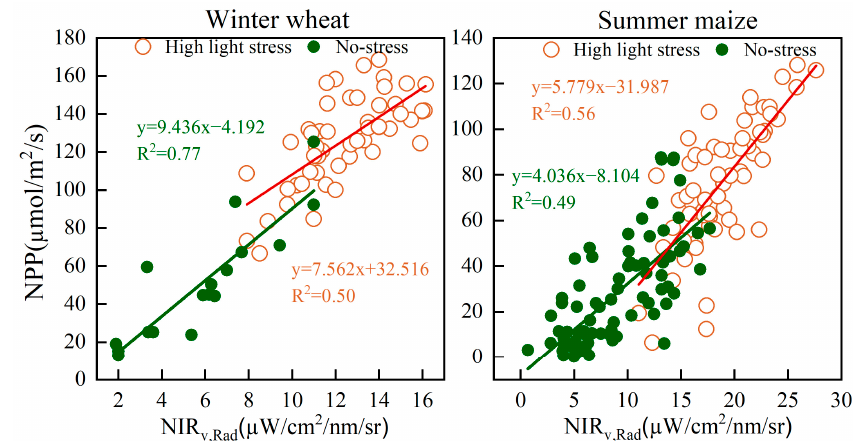
Figure 8. Scatter plots of NIR v,Rad -NPP correlations at the hourly scale for winter wheat (C3) and summer maize (C4) under high light stress and non-stress conditions, coefficient of determination (R 2 ), red solid lines indicate fitted curves of NIR v,Rad -NPP under high light stress, green solid lines indicate fitted curves of NIR v,Rad -NPP under non-light stress.